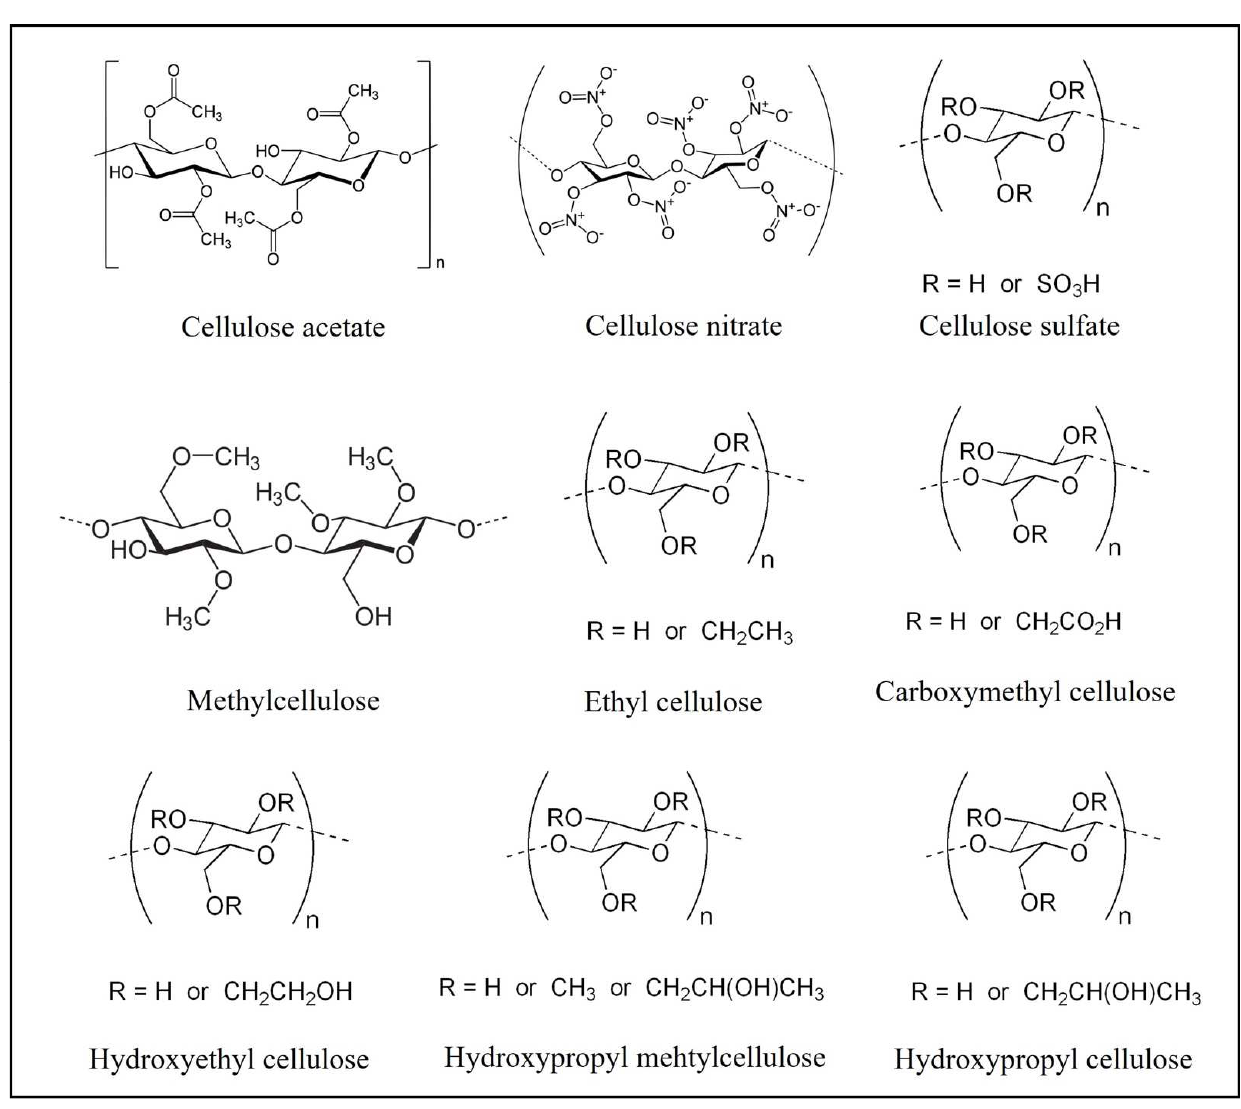
Figure 5. Examples of cellulose derivatives and respective molecular structure.